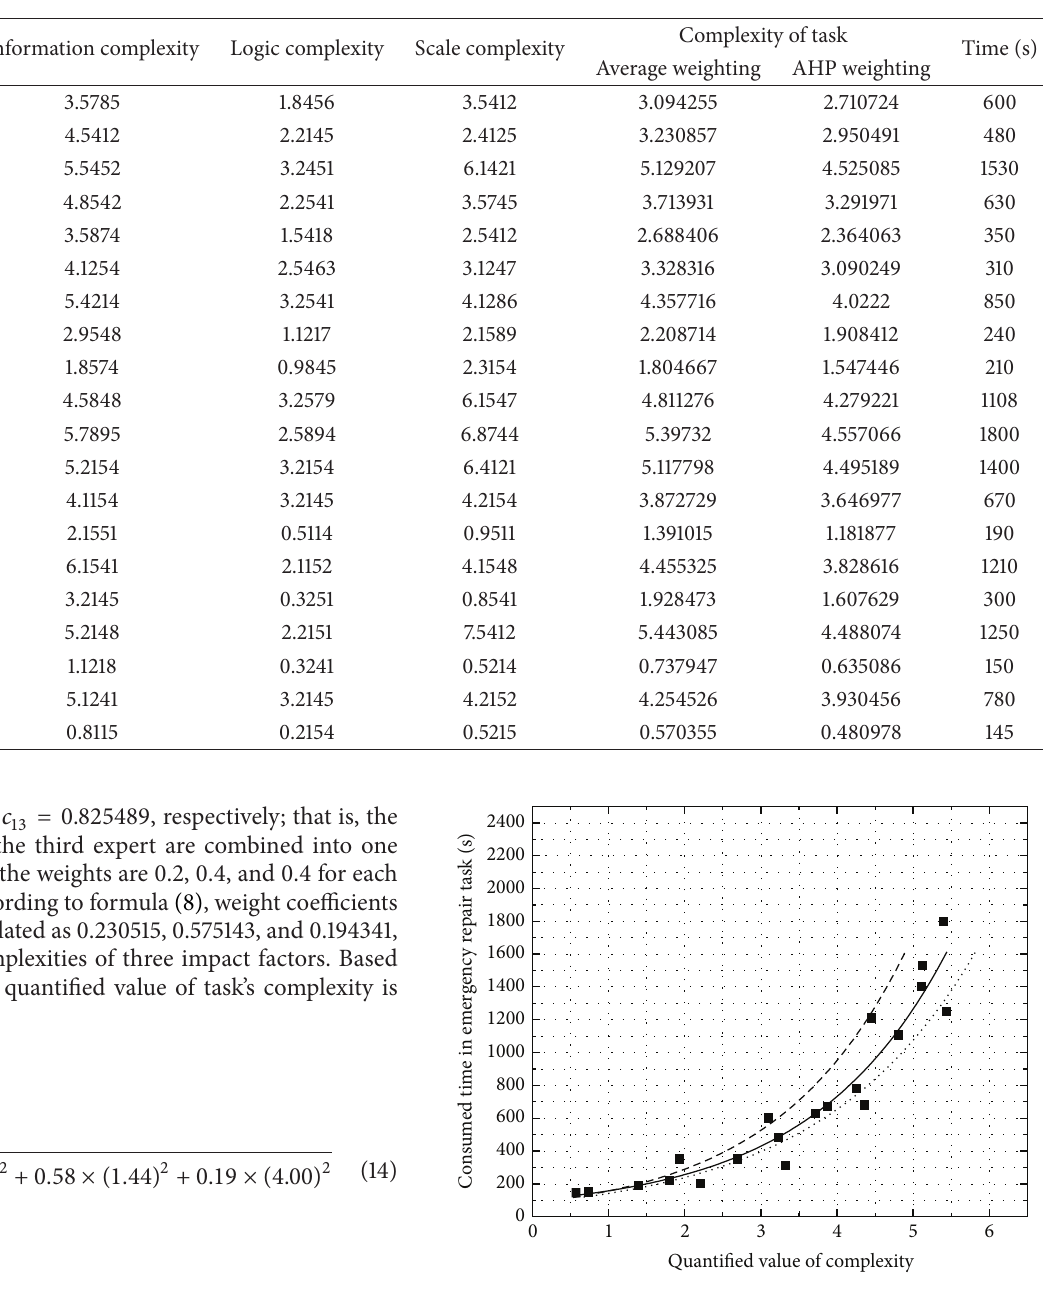
Top prediction curve of 95 % Bottom prediction curve of 95% Figure 5: Complexity quantification based on average